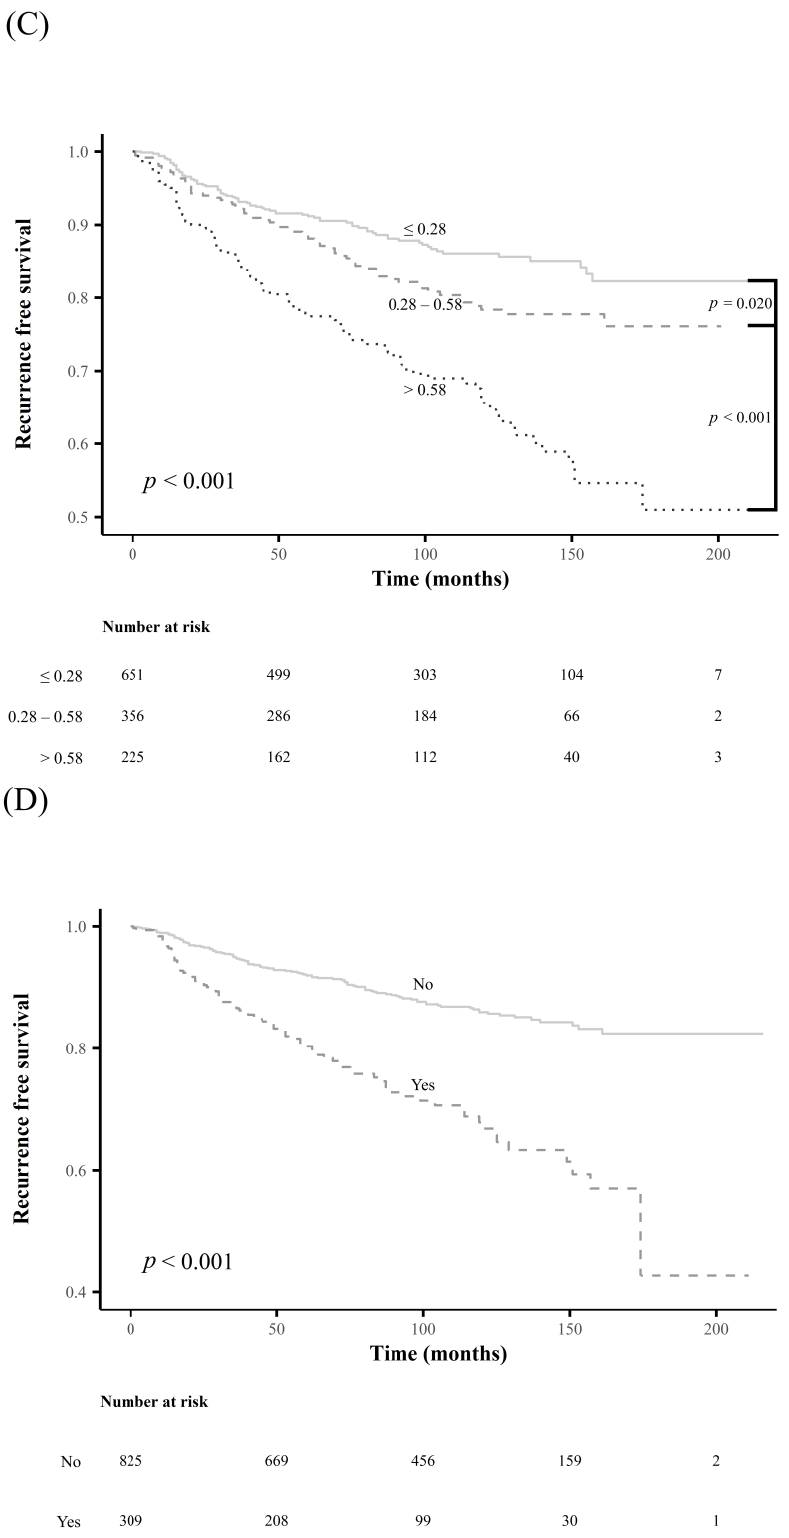
Figure 3. Comparison of the recurrence-free survival rates between the subgroups according to the newly determined cutoff values for LN-related risk factors: ( A ) maximal diameter of metastatic LN foci, ( B ) number of metastatic LN, ( C ) metastatic LN ratio, and ( D ) extranodal extension.